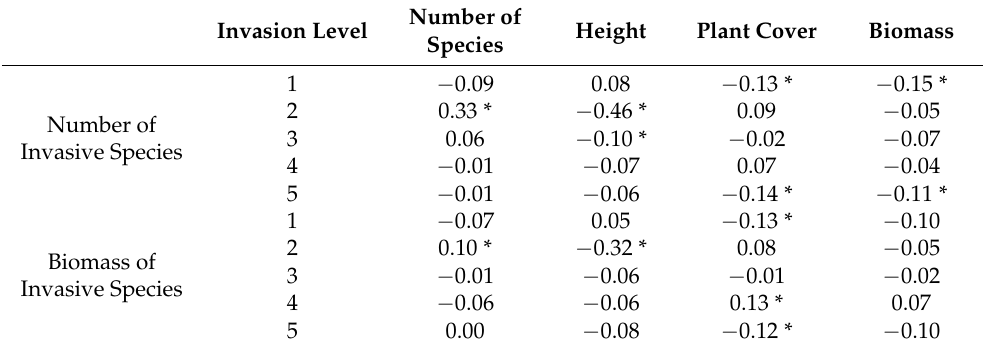
Table 4. Pearson’s correlation coefficients between invasion intensity and plant community character- istics. * indicates significant correlation at the level of 0.05. Number of Height Plant Cover Biomass Invasion Level Species 1 − 0.09 0.08 − 0.13 * − 0.15 * 2 0.33 * − 0.46 * Number of Invasive Species